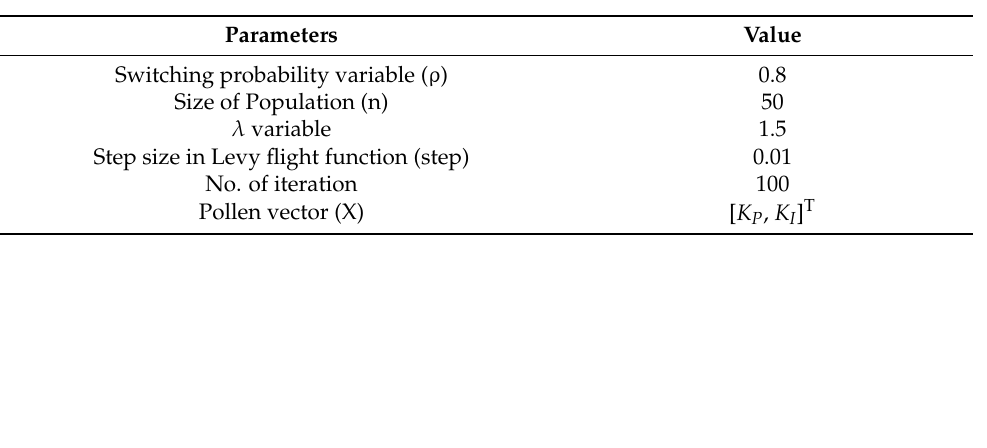
Table 2. SynRM nominal model parameters and their parametric